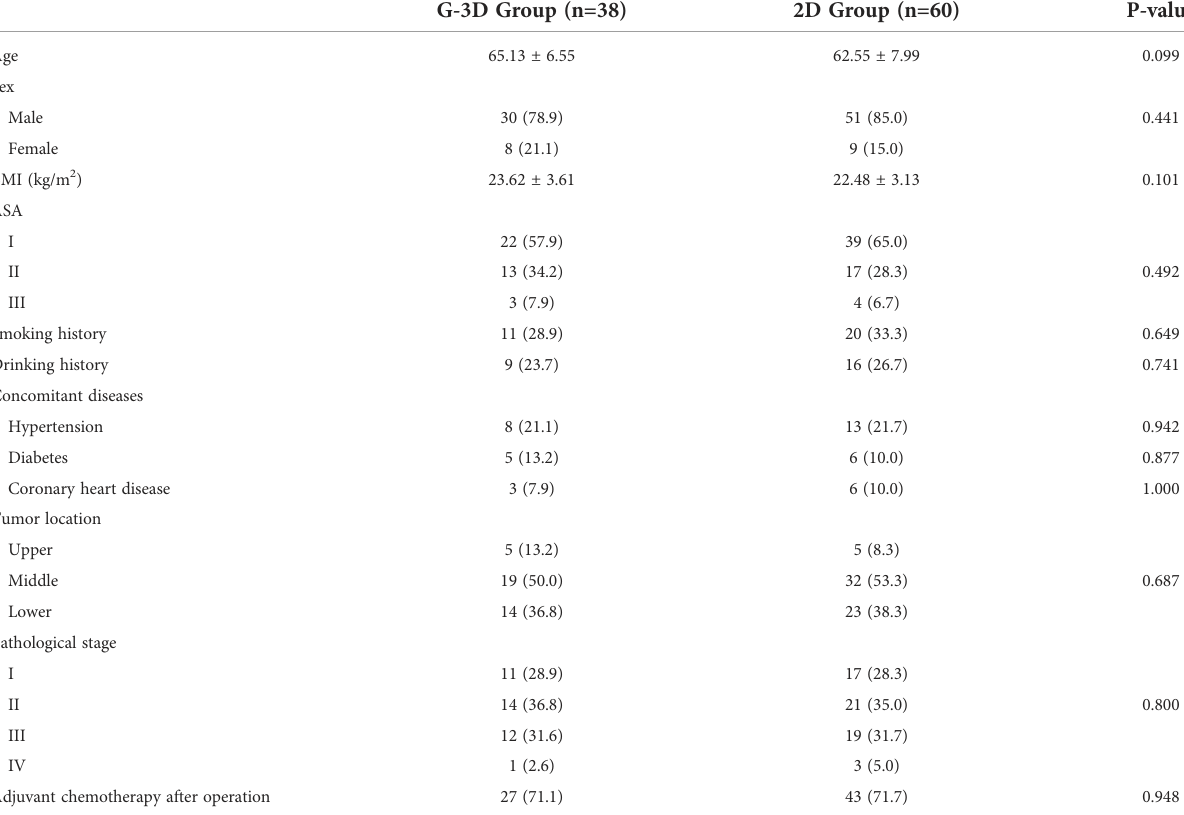
TABLE 1 Summary of patient characteristics [ (cid:1) x ± s